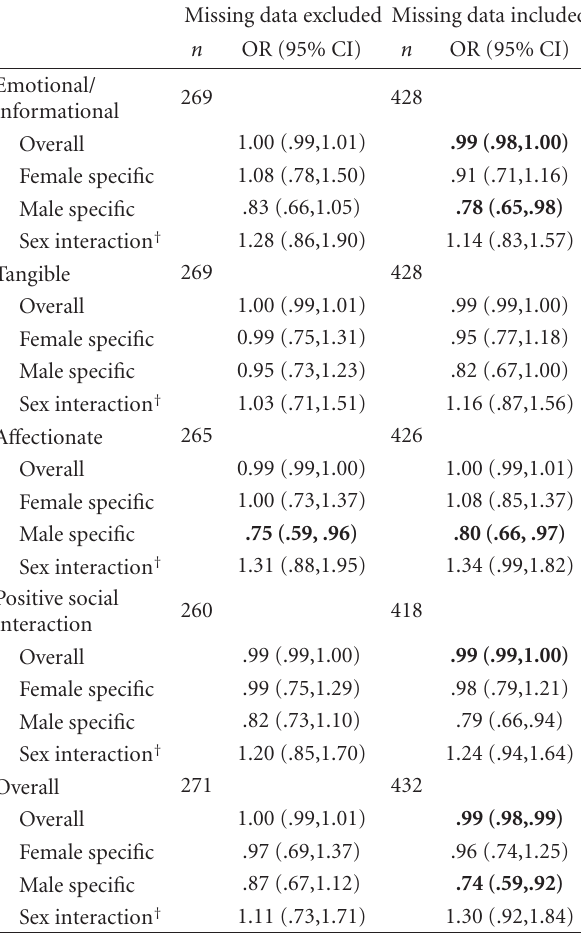
Missing data excluded